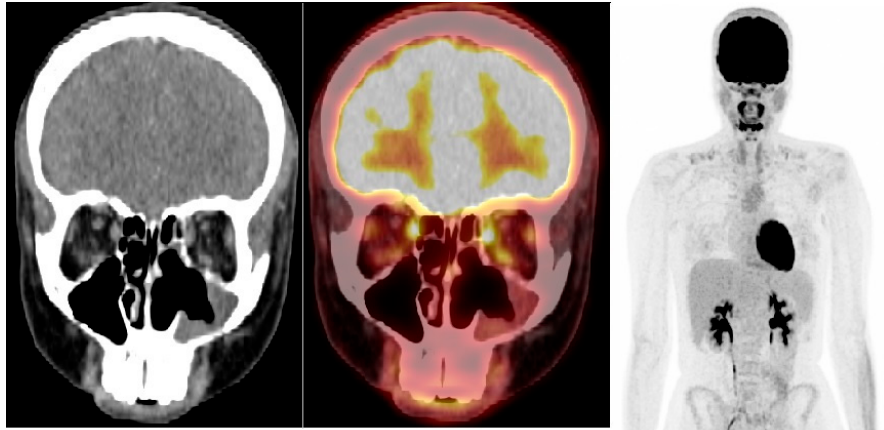
Figure 2. Follow-up scan—Left and middle: CT and fused 18 F-FDG PET/CT, coronal view; right: